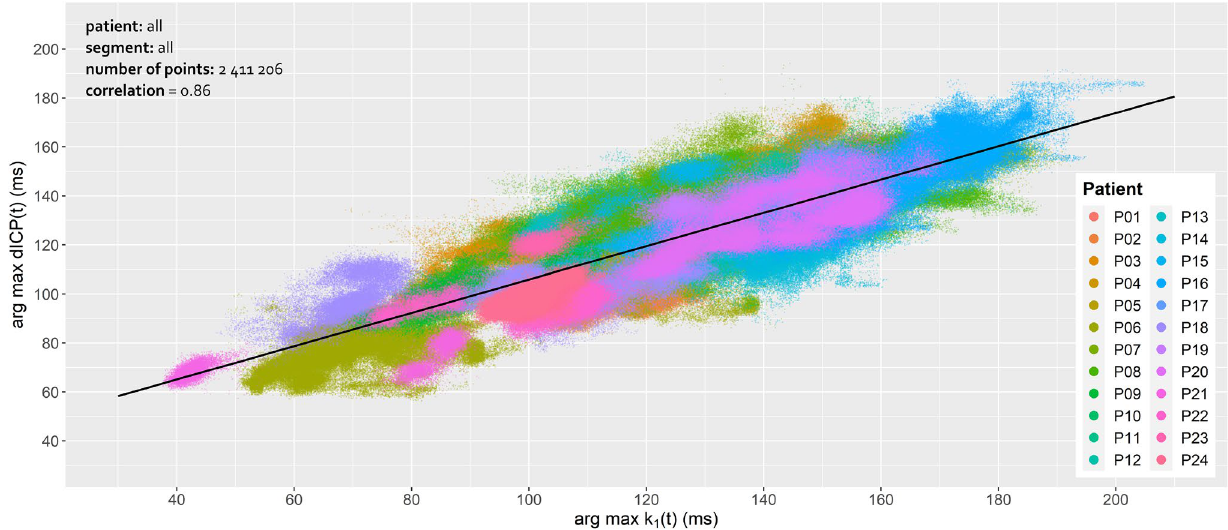
Figure 5. Correlation analysis for all segments. Correlation between the selected k 1 (t) and the first dICP maximum (ms) drawn for all 24 patients. The figure was generated using R 4.0.0 (R Core Team (2020). R: A language and environment for statistical computing. R Foundation for Statistical Computing, Vienna, Austria. URL https:// www.R- proje ct. org/.) with ggplot2 3.3.2 (H. Wickham. ggplot2: Elegant Graphics for Data Analysis. Springer-Verlag New York,